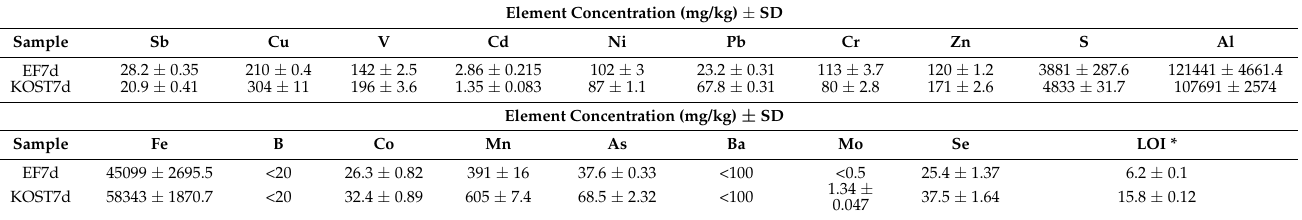
* Loss on ignition at 950 ◦ C.